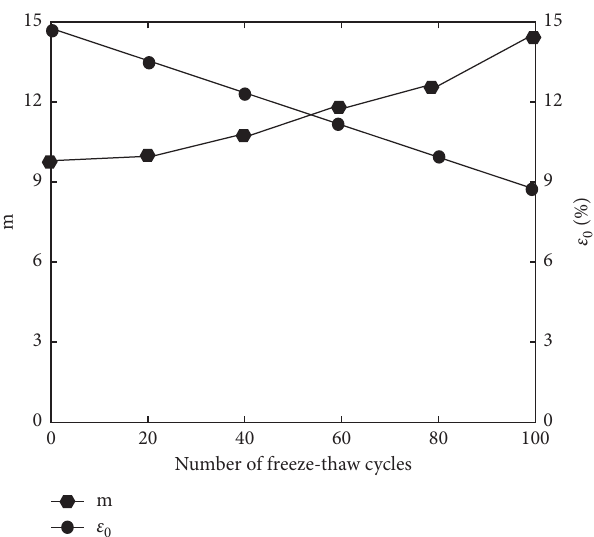
Figure 5: Curve of damage evolution parameters with freeze-thaw